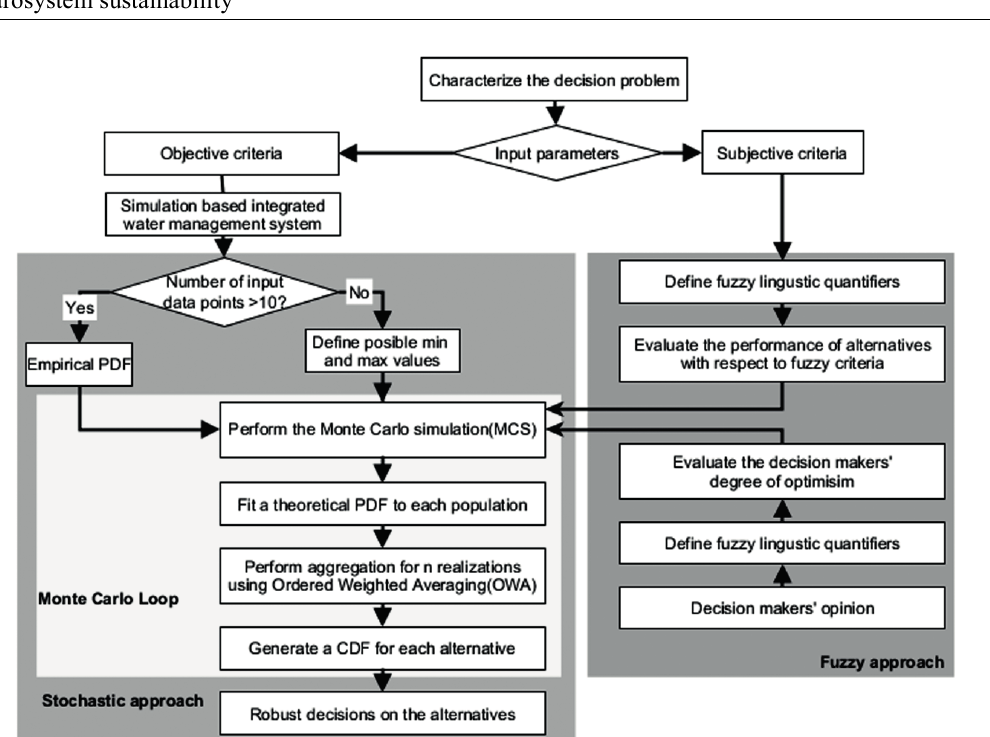
Fig. 1 Flow chart of the multi-criteria multi-stakeholder decision analysis using a fuzzy-stochastic